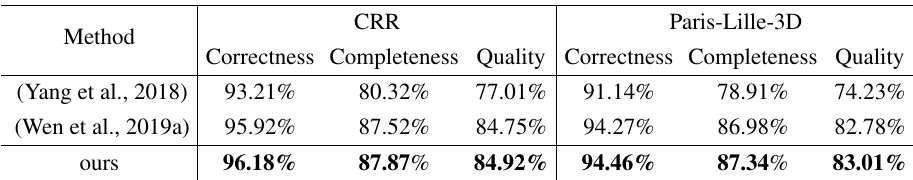
Table 4. Road marking extraction results on CRR and Paris-Lille-3D dataset, respectively. Our method achieves best performance on two dataset compared with other competitive methods.